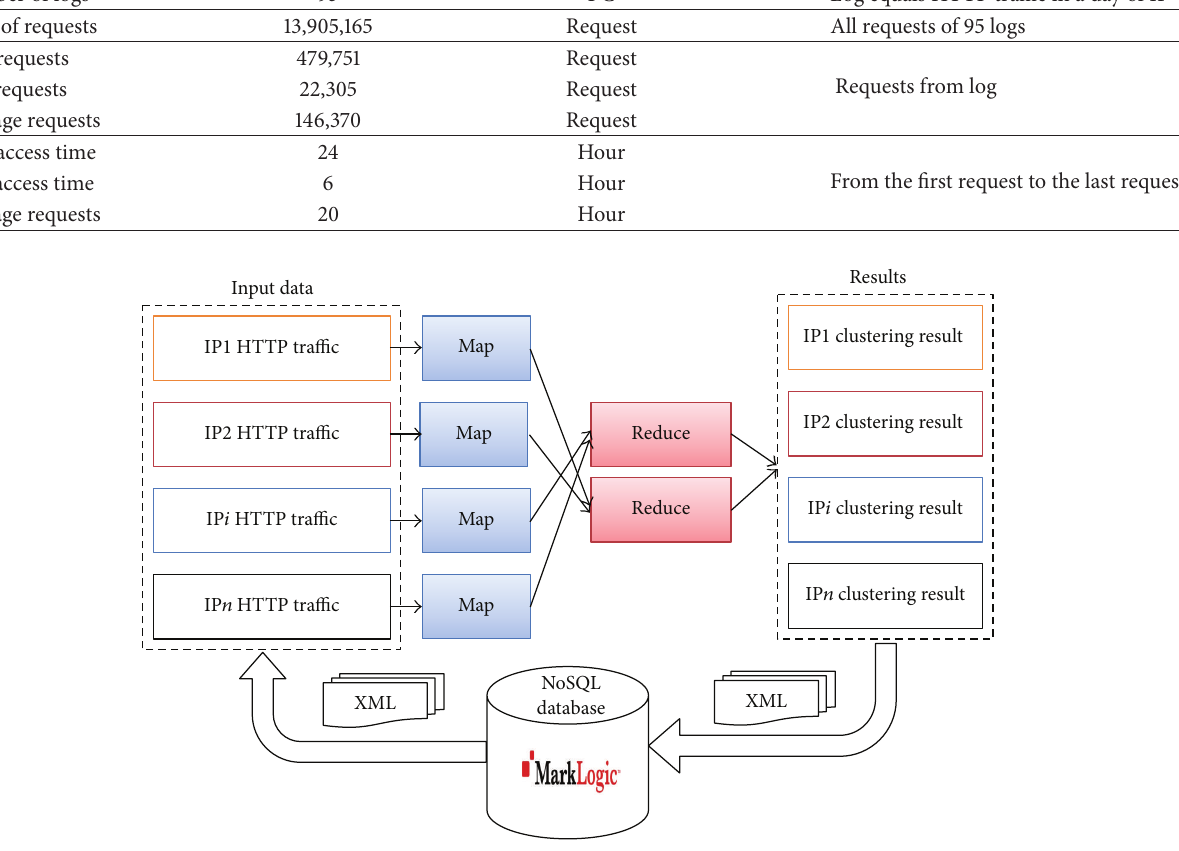
Figure 10: Process flow of clustering